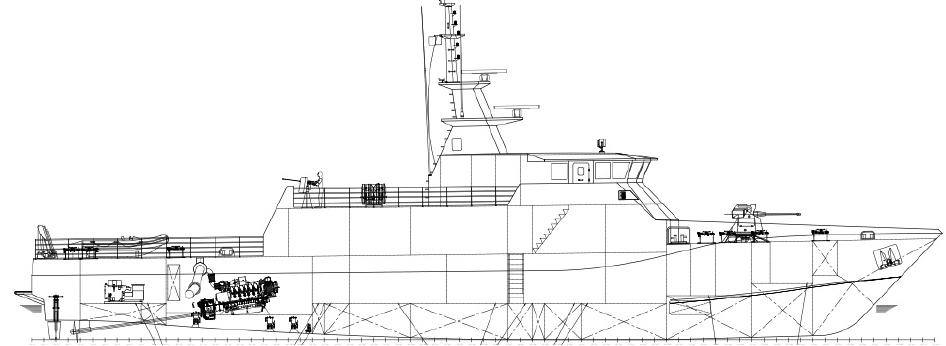
Figure 2. Indonesian Warship KCR 40